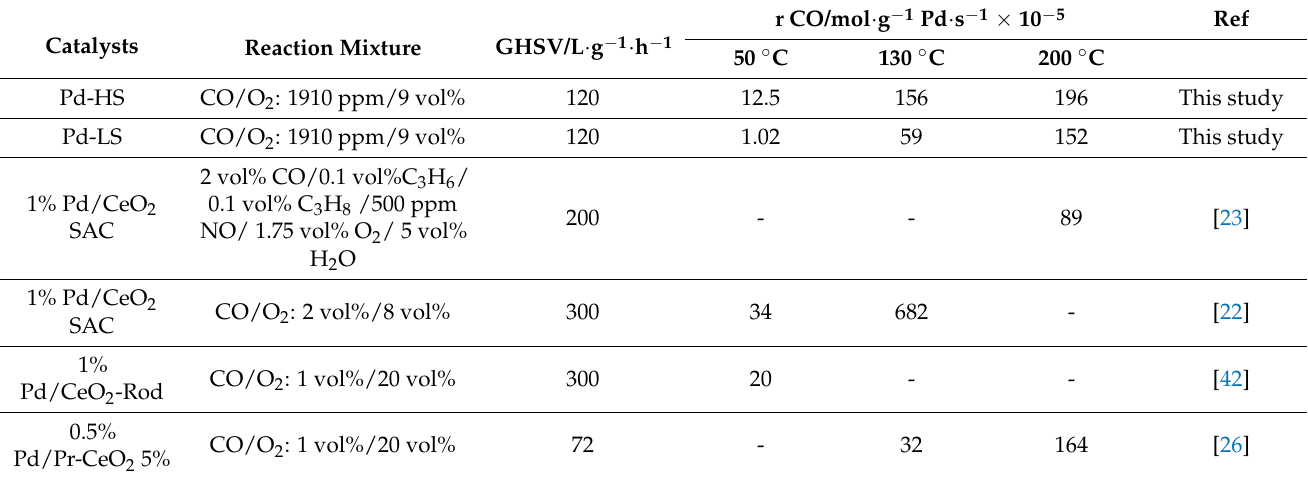
Figure 7. CO conversion for Pd/CZP45-LS and Pd/CZP45-HS. Reaction mixture: CO/O 2 : 1910 ppm/9 vol%. Table 4. Catalytic activity for CO oxidation of Pd-HS and Pd-LS, comparison with the literature data.